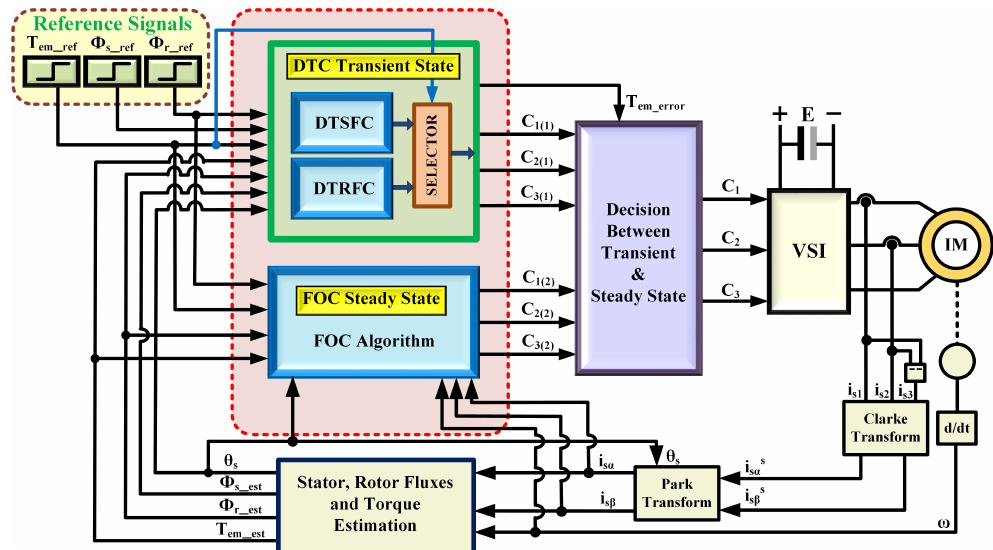
Figure 5. The proposed combined FOC-DTC algorithm.